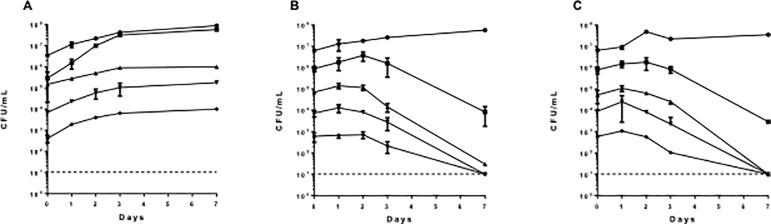
The effects of inoculum size on compound activity.Aerobic cultures were exposed to compounds at 10X MIC over 7 days. Bacterial viability was determined by counting CFU. (A) DMSO, (B) Compound 1, (C) 2. The starting inoculum was: (●) 107, (■) 106, (▲) 105, (▼) 104, and (♦) 103.The dashed line represents the lower limit of detection.